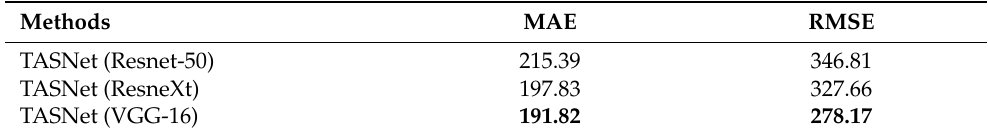
Table 5. Comparative results of different backbones on the ship dataset. The best performances are highlighted in bold .